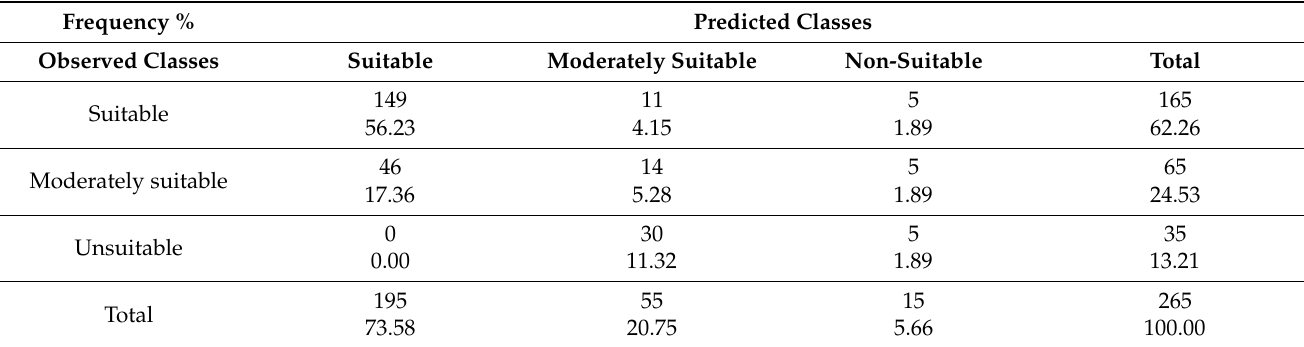
Table 6. Classified assessment of the expert model.